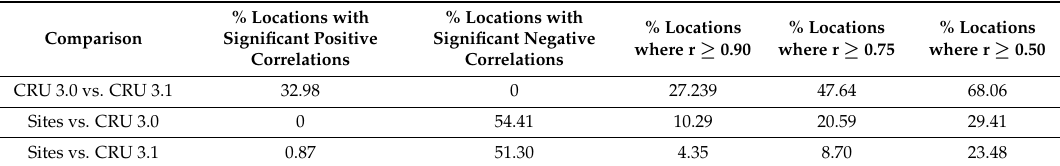
Table 4. Comparison of interdecadal variability in April 1 SWE/cumulative October–March SFE.